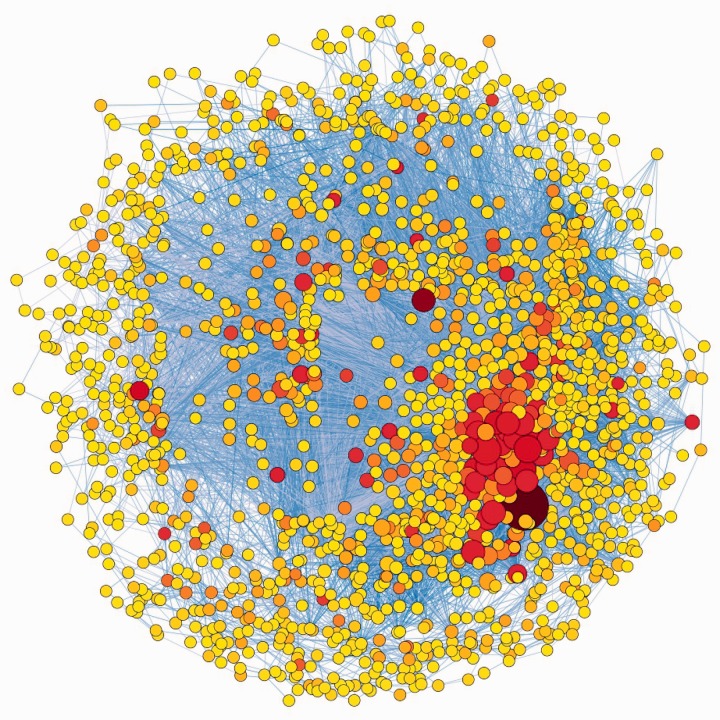
A partial rendering of the Arabidopsis whole-genome network. The illustrated network represents a union of all the shortest paths between each pair of the top 5% of the hubs in the whole-genome network (Supplementary Table S4). It contains 1556 genes and 22 073 interactions. The network topology is displayed using Cytoscape with the size of a node proportional to its degree and the intensity of its color proportional to its betweenness centrality. The largest and the darkest node in the bottom right-hand corner of the figure is PMDH2, a gene involved in photorespiration.